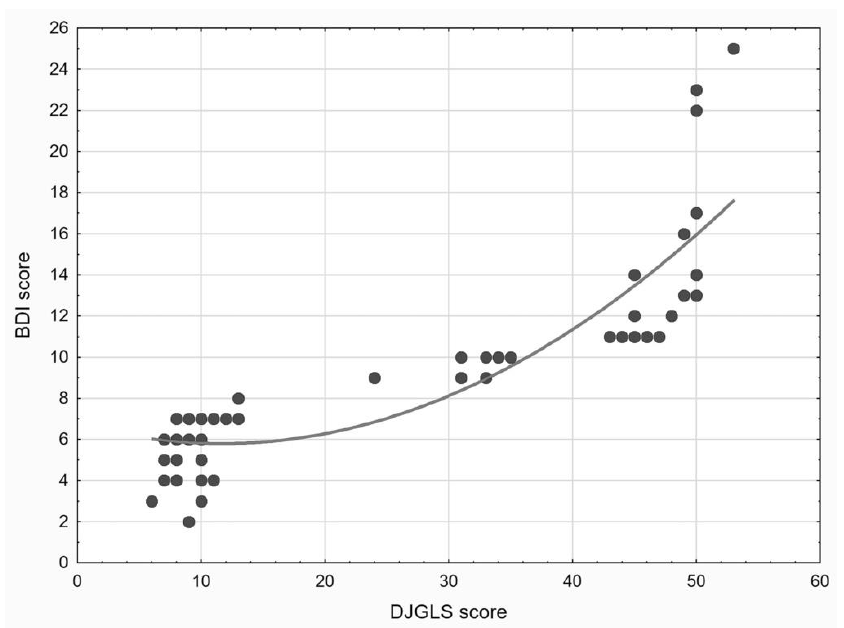
Figure 1. A scatter plot depicting the association between the De John Giervald Loneliness (DJGLS) scale score and Beck Depression Inventory-II (BDI) score in the studied group of the older adults living in the city and in the rural area. The curve indicates the modelled, non-linear relationship between the two scores.